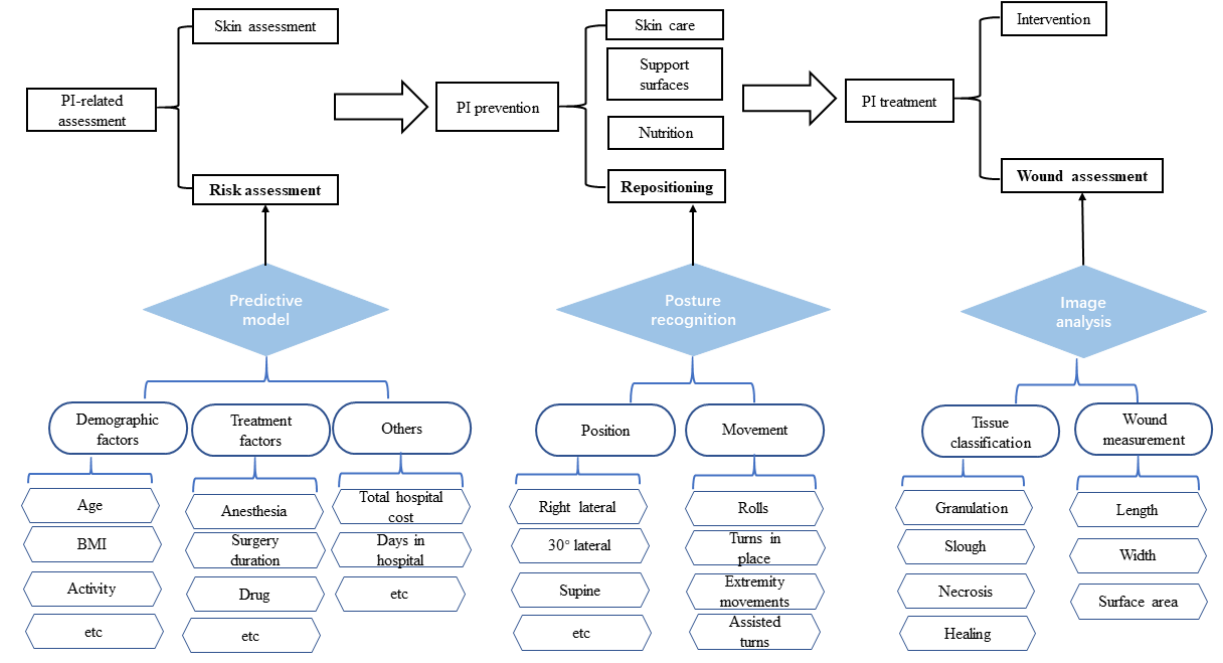
Figure 2. The roles of machine learning technologies used in pressure injury (PI)